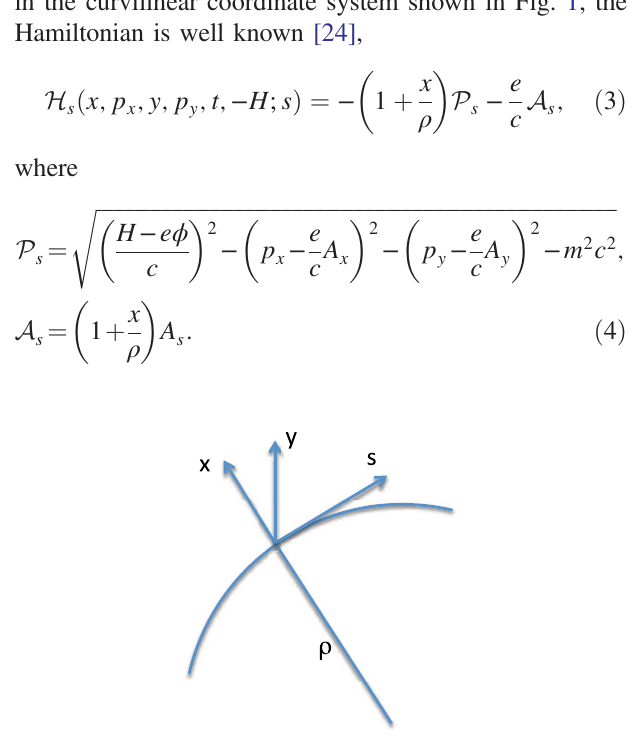
FIG. 1. The curvilinear coordinate